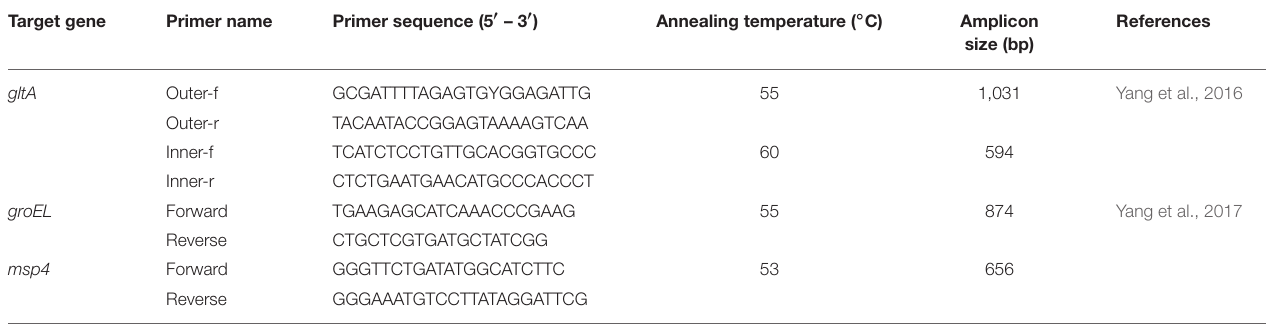
TABLE 1 | Primers and PCR amplification conditions for A. capra .